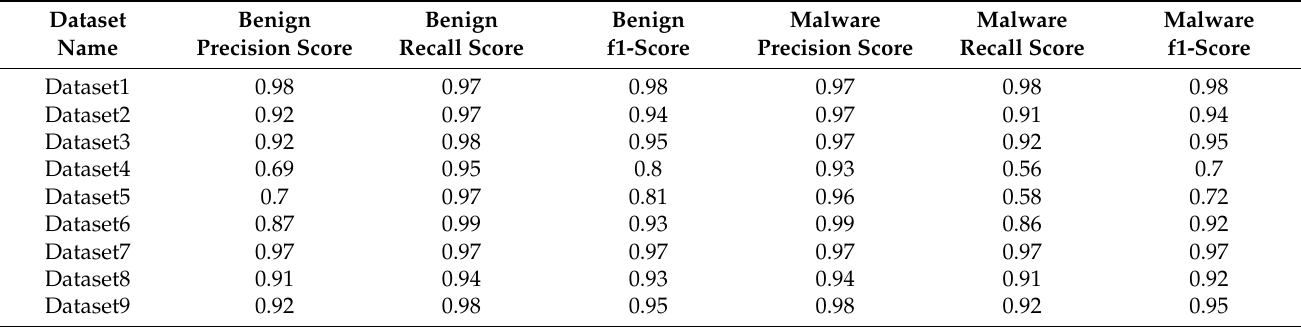
Table 8. Test results when using the deep learning algorithm.